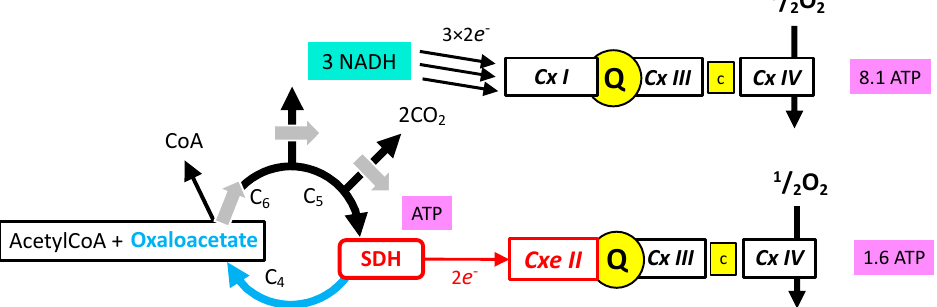
Figure 7. ATP formation resulting from one round of TCA. TCA itself generates one ATP. Entry into Oxphos by complex I (CxI) reoxidizes the 3 NADH (3 × 2.7 = 8.1 ATP), and by complex II (SDH) 1.6. These values [19] are the theoretical (maximal values) with full (100%) coupling between electron transfer (complexes I, III, IV or II, III, IV) and phosphorylation by complex V (not shown here). Depending on the authors, the physiological coupling ranges from almost 100% to 50%, and ATP yield for Oxphos would change accordingly. The production of ATP by TCA is stoichiometric with the reaction succinylCoA to succinate + acetylCoA, hence not affected by a coupling ratio. If complete oxidation of glucose is considered, the theoretical yield is 32–34